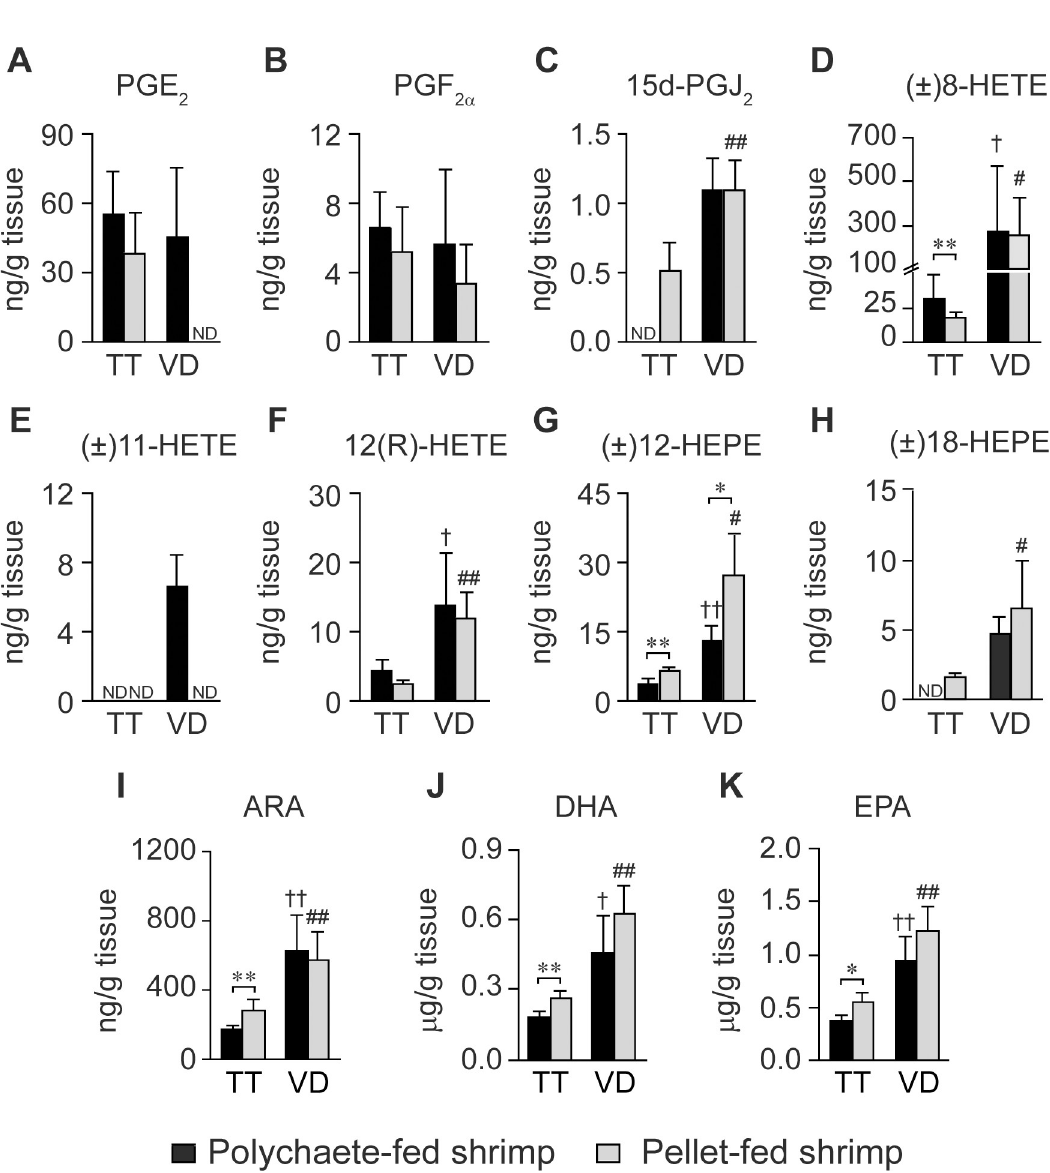
Fig 7. Comparative analysis of eicosanoid and PUFA levels in testes and vas deferens of eleven-month-old, domesticated shrimp fed with polychaetes or feed pellets. Levels of (A) PGE 2 , (B) PGF 2 α , (C) 15d-PGJ 2 , (D) ( ± )8-HETE, (E) ( ± )11-HETE, (F) 12 (R)-HETE, (G) ( ± )12-HEPE, (H) ( ± )18-HEPE, (I) ARA, (J) DHA, and (K) EPA were compared between polychaete- (black bar, N = 5) and pellet-fed shrimp (gray bar, N = 5). Error bars represent standard deviations. Asterisks indicate statistically significant differences in metabolic levels between polychaete- and pellet-fed shrimp using the t -test ( � for P < 0.05 and �� for P < 0.01). Daggers indicate statistically significant differences in metabolic levels between testes and vas deferens of polychaete-fed shrimp using the t -test († for P < 0.05 and †† for P < 0.01). Hashes indicate statistically significant differences in metabolic levels between testes and vas deferens of pellet-fed shrimp using the t -test (# for P < 0.05 and ## for P < 0.01). ND means that the designated metabolite was not detected.